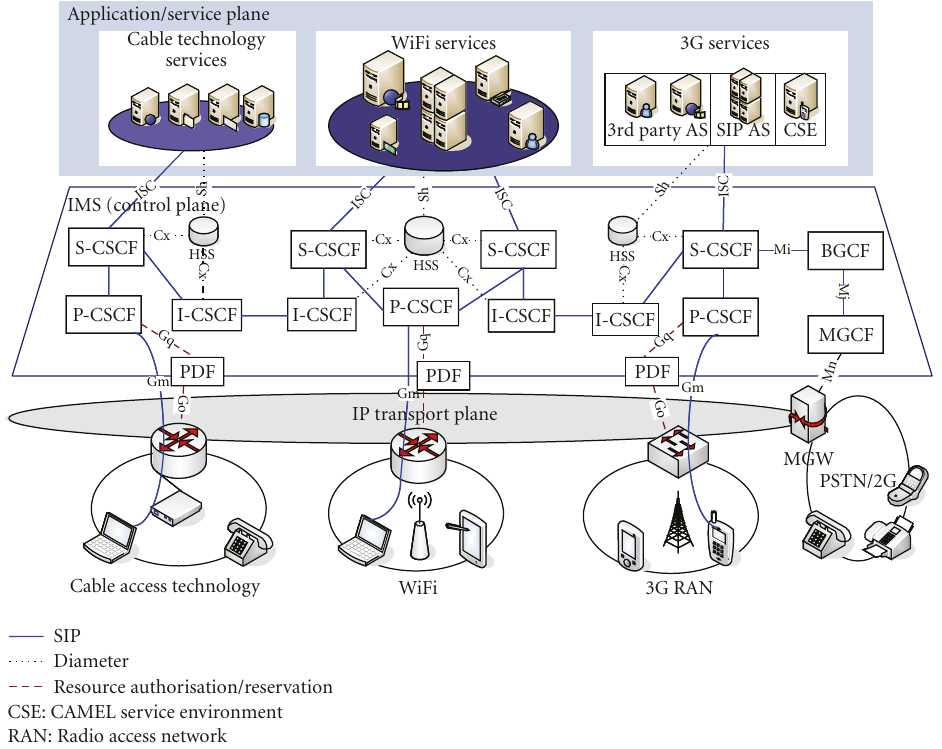
Figure 3: IMS Overlay architecture and blended multiple